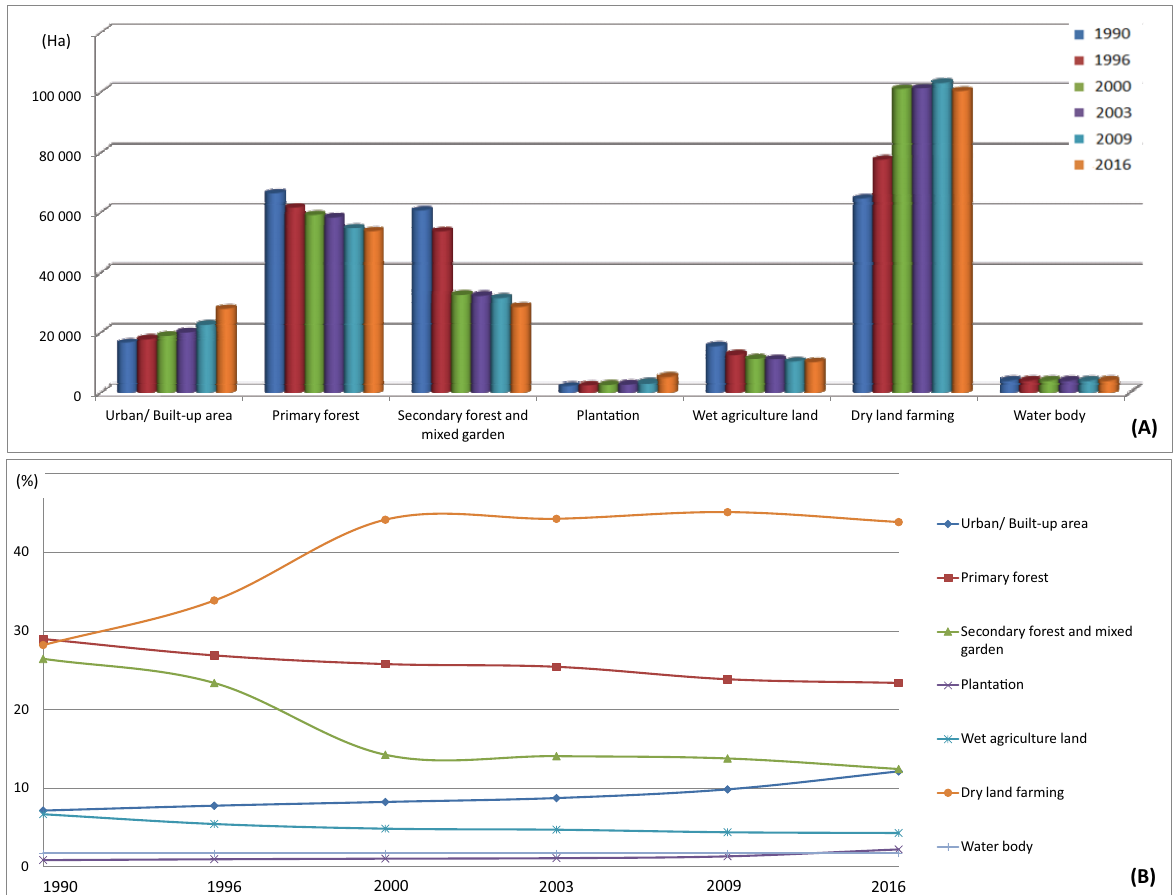
Fig. 4. The dynamics of LULC changes during the period 1990–2016 in the study area. A – estimated area in LULC changes (in hectares), B – Trends and percentages in LULC changes (in per